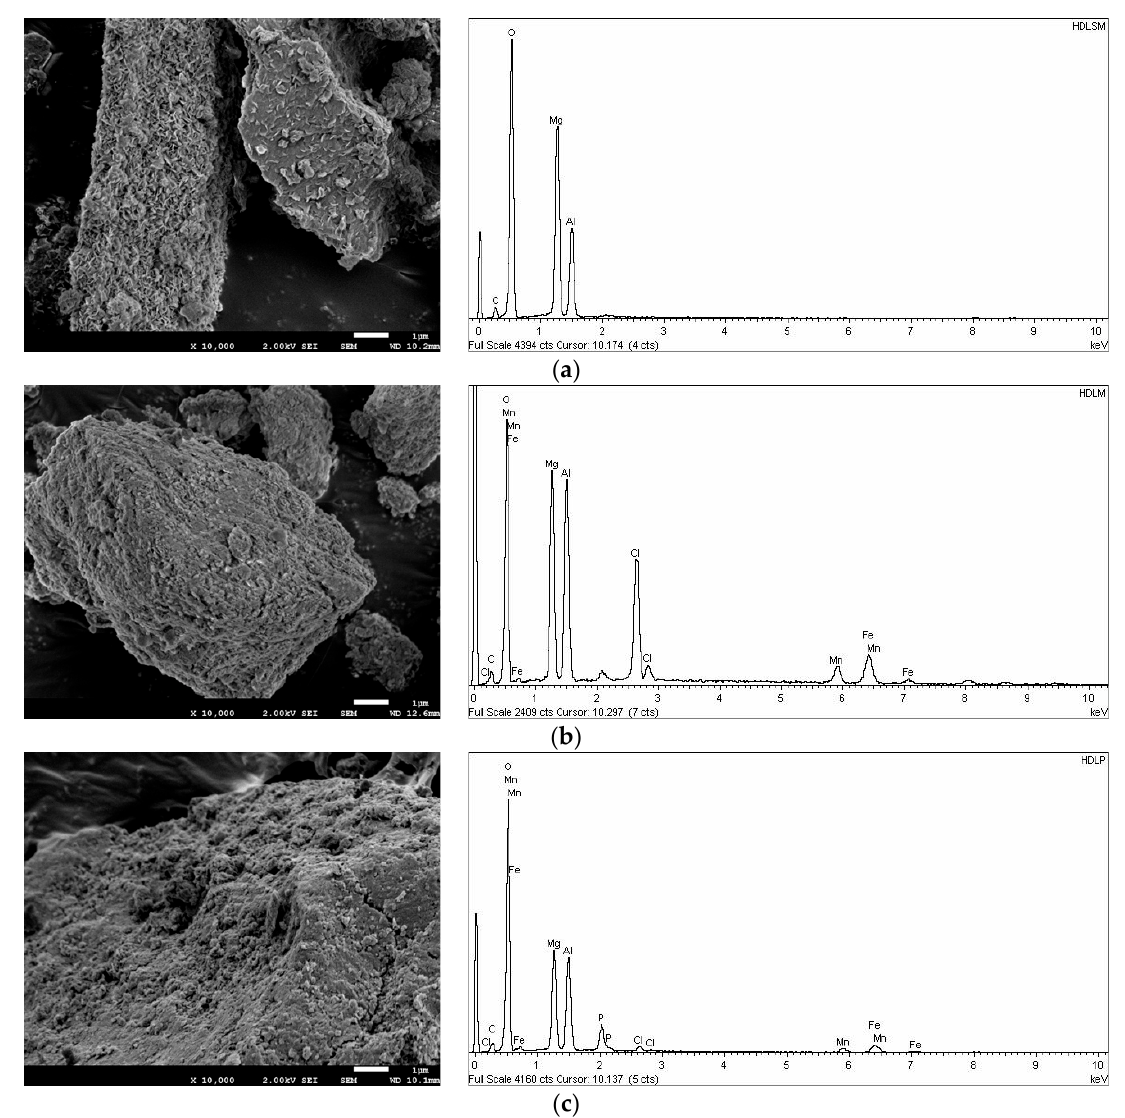
Figure 2. SEM–EXD of the LDH materials ( a ) Mg-Al-LDH, ( b ) Mn 2+ /Zn 2+ /Fe 3+ /Mg-Al-LDH compo- site and ( c ) P-loaded Mn 2+ /Zn 2+ /Fe 3+ /Mg-Al-LDH